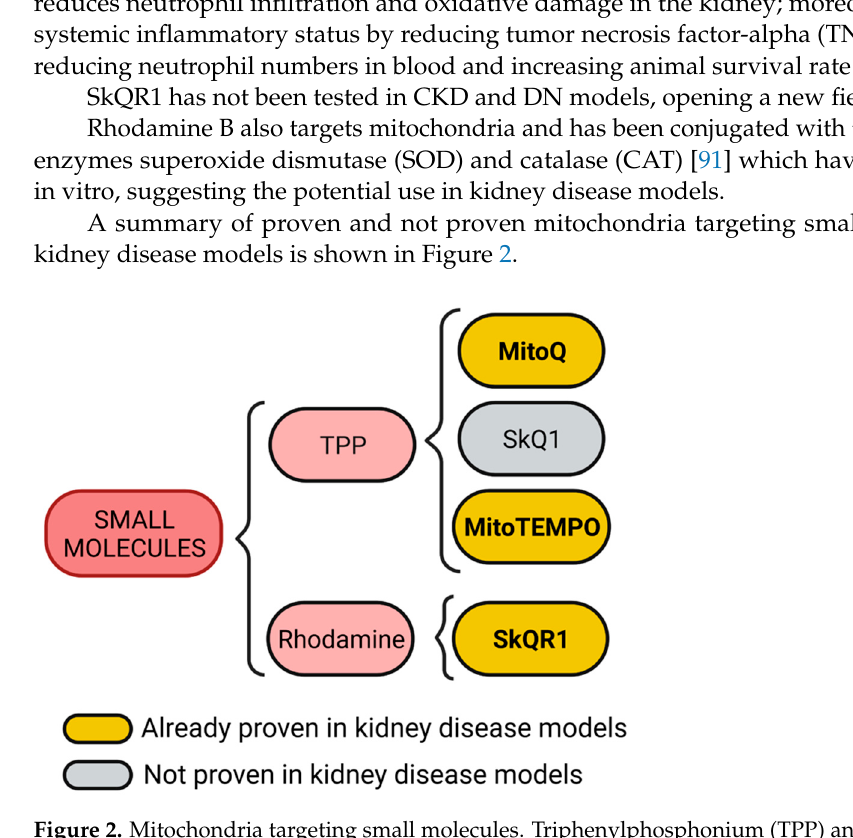
Figure 2. Mitochondria targeting small molecules. Triphenylphosphonium (TPP) and rhodamine are small molecules with cationic and lipophilic characteristics. TPP can be conjugated with quinone, plastoquinone, or 2,2,6,6-tetramethylpiperidine-N-oxyl (TEMPO) to generate mitoQ, SkQ1, and mitoTEMPO molecules, respectively. On the other hand, rhodamine conjugated with plastoquinone generates the SkQR1 molecule. Figure created with BioRender.com.